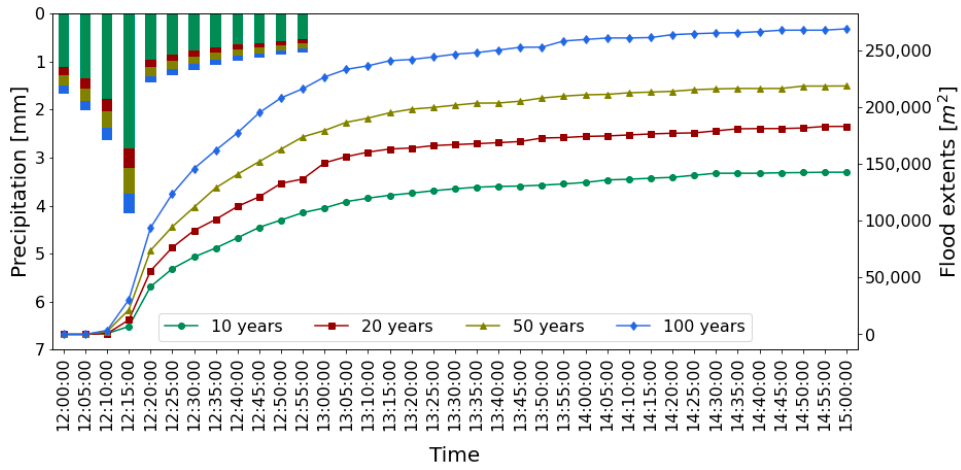
Figure 4. Time series of flood extents for design storm events for all return periods (10-, 20-, 50-, and 100- year).